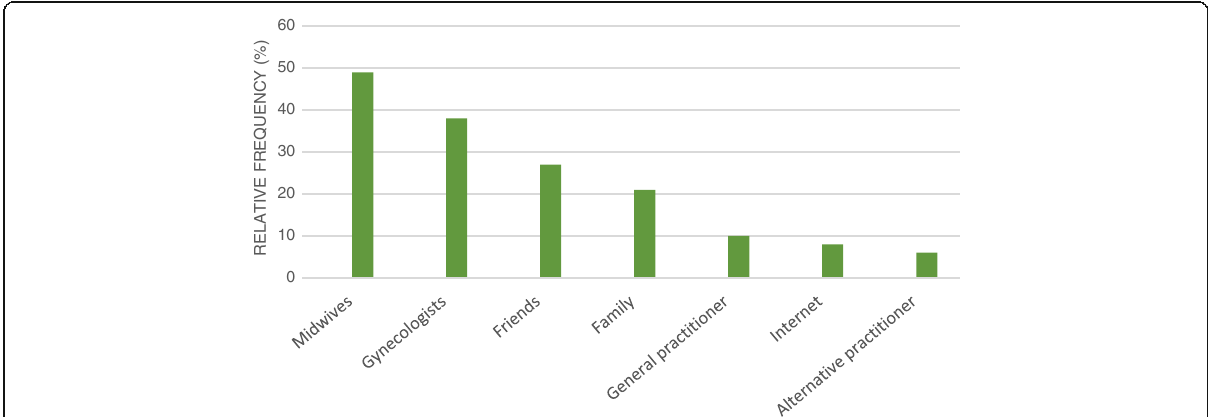
Fig. 2 Sources of recommendation which had the strongest influence on participants using CAM specifically in relation to their pregnancy or childbed ( n = 177). Multiple responses were possible